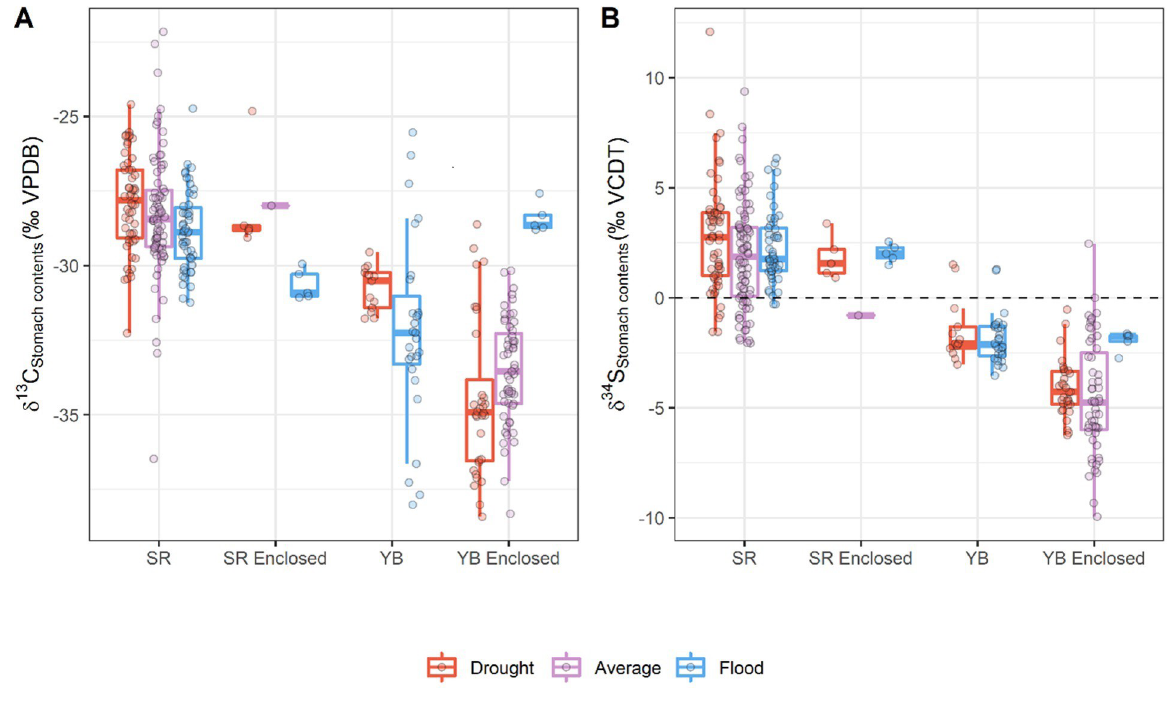
Fig 4. δ 13 C (A) and δ 34 S (B) values of stomach contents from river and floodplain habitats under different hydrologic conditions. δ 34 S values from the stomach contents of fish that reared on the floodplain were consistently lower throughout all years (2012–2015, drought; 2016, average; 1999 and 2017, flood). The δ 13 C values were also generally lower, but this trend varied with different hydrologic conditions. Box denotes the median and interquartile range, and whiskers denote 1.5 time the interquartile range.